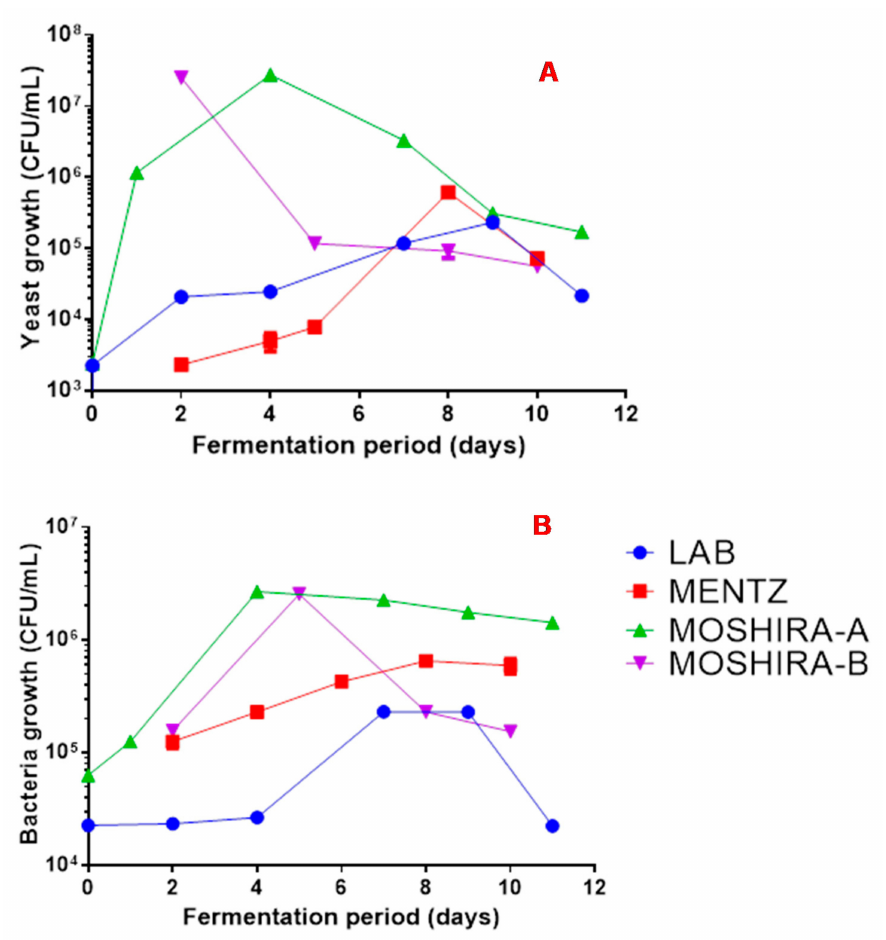
Figure 3. Yeast ( A ) and bacterial ( B ) content during marula wine